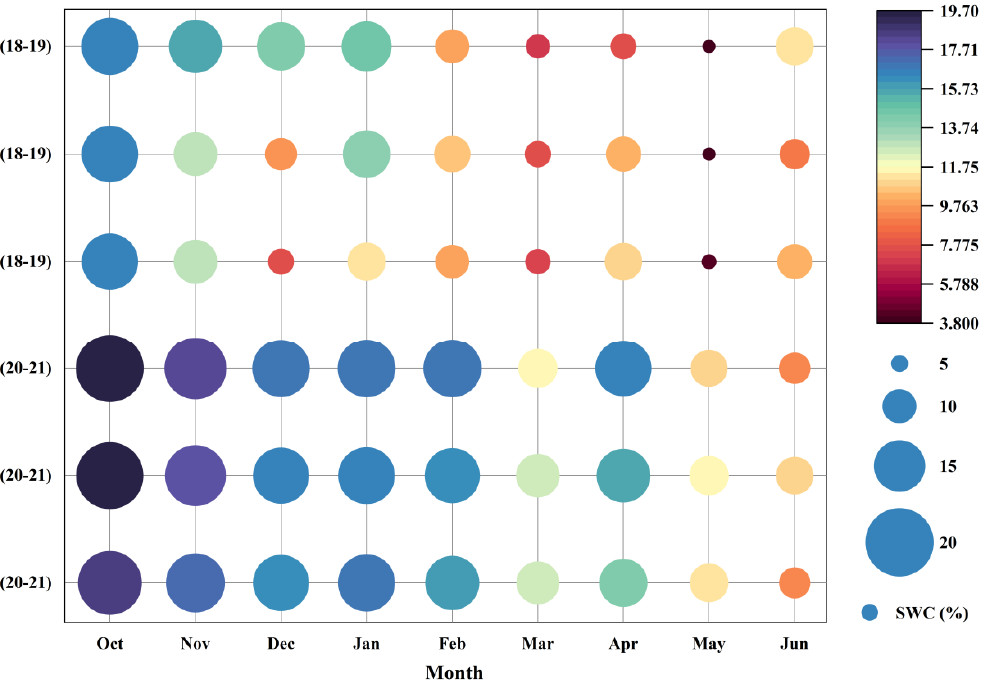
Figure 3. Changes in soil water content in the 0–20 cm soil layer under different amounts of added biochar during the winter wheat growing seasons in 2018–2019 and 2020–2021. Note: SWC represents soil water content. Both the size and color of the circle represent the level of soil water content. B20, B10, and B0 represent 20, 10, and 0 Mg biochar ha –1 , respectively. The soil temperature at a depth of 10 cm decreased initially and then increased under each treatment during the wheat growth process, with a trough period in December–January (Figure 4). The application of biochar affected soil temperature. With B0 as the control, the increasing range of soil temperature in different months varied from − 6.67% to 8.57% and from − 3.64% to 16.67% under B10 and B20, respectively (Figure 4). Overall, the application of biochar reduced the variations in the soil temperature range to some extent and increased the average soil temperature during the wheat growth period. Compared with B0, the average soil temperatures were 1.96–3.53% and 0.98–2.35% higher under B10 and B20, respectively (Figure